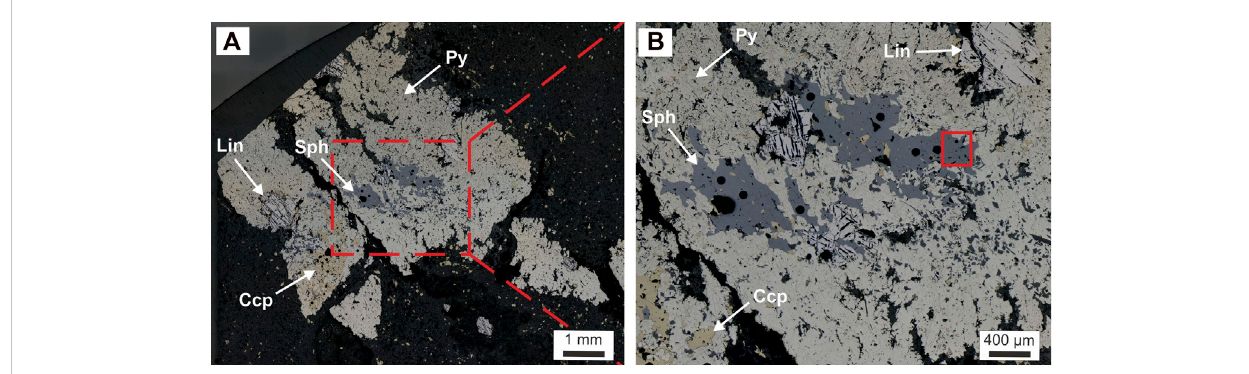
FIGURE 3 Re fl ective light micrographs of the cluster mineralization style of the DOF containing the Co-rich sphalerite investigated in this study. (A) Overview micrograph of the cluster mineralization. (B) Close-up micrograph with a solid red square indicating the targeted area investigated within this study. Shown here is also the sphalerite clearly replacing pyrite and linnaeite. Round black holes in the sphalerite are laser ablation pits.